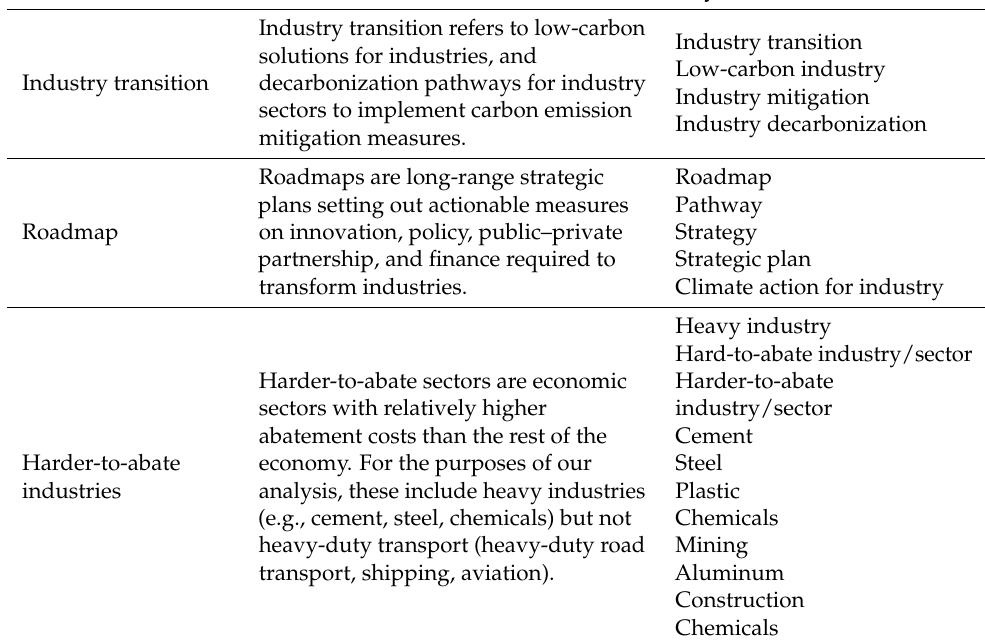
Table 1. Search terms and key words. Term Key Search